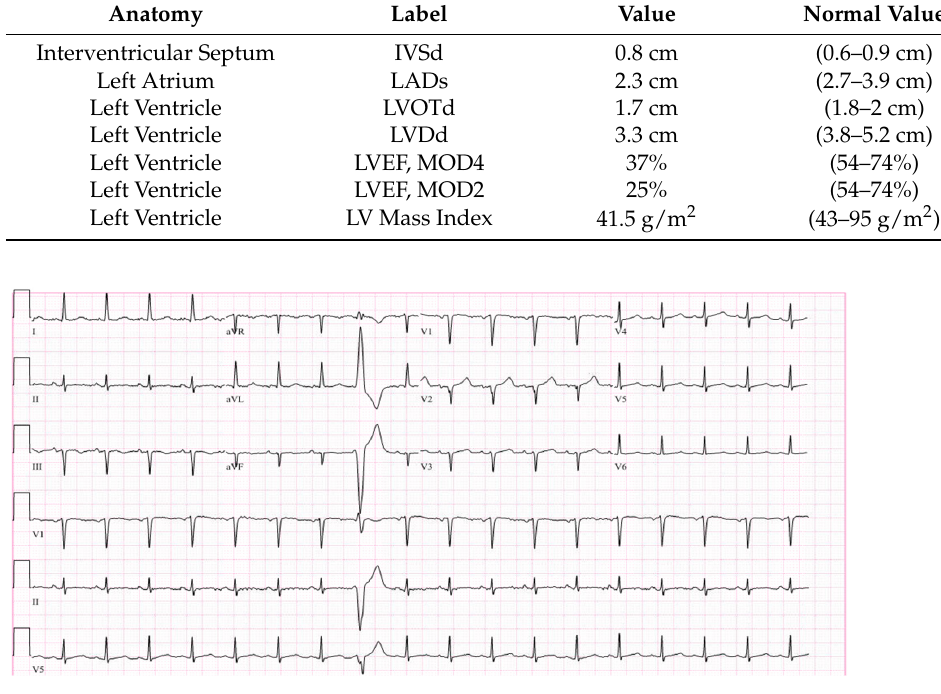
Figure 2. EKG showing premature ventricular complexes and poor precordial lead R wave progres ‐ sion.